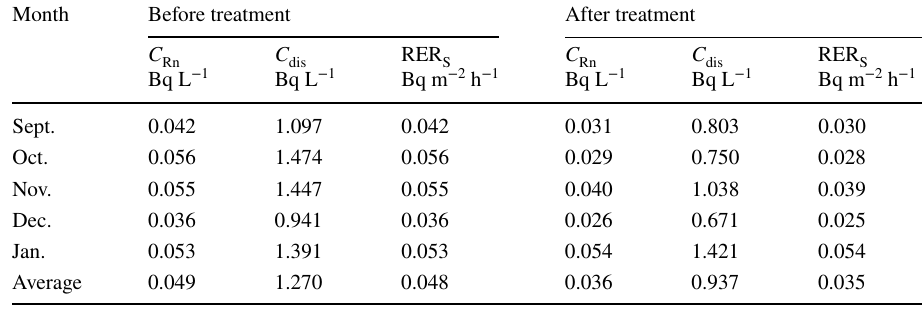
Fig. 3 Radon activity levels in wastewater samples before and after treatment